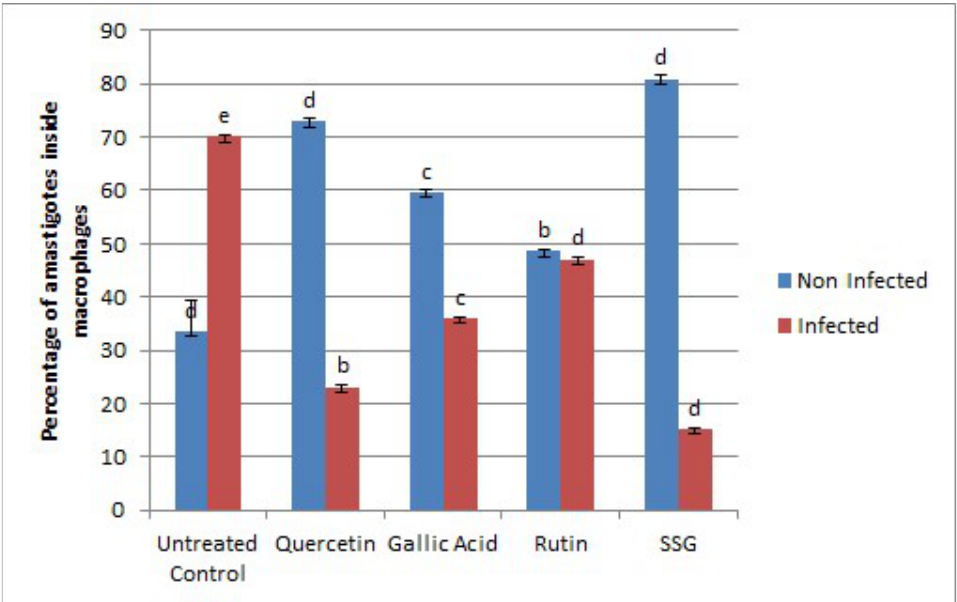
Figure 5. Percentage of amastigotes inside BMDMs infected with transgenic L. donovani parasites. Treatment was conducted with quercetin, gallic acid, and rutin at their 50% inhibitory concentra- tions (IC 50 ) (84.65 µg/mL, 86 µg/mL, and 98 µg/mL, respectively) for 72 h. SSG at 250 µg/mL was used as a positive control. Data represent the mean values of three replicates with ± standard error. Different labels on columns show significant difference at p < 0.05.